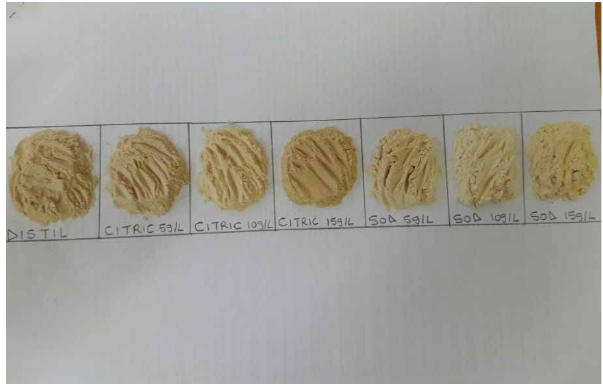
Figure 1: Ndou sweet potato